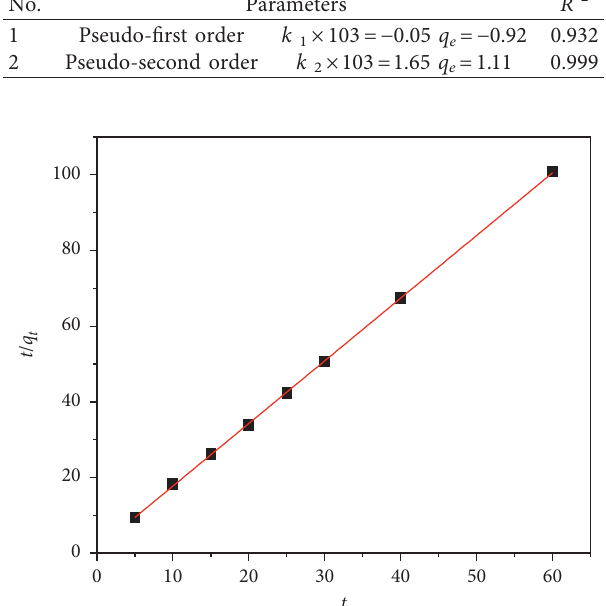
Figure 12: Pseudo-second order for adsorption of brilliant green dye onto AC.